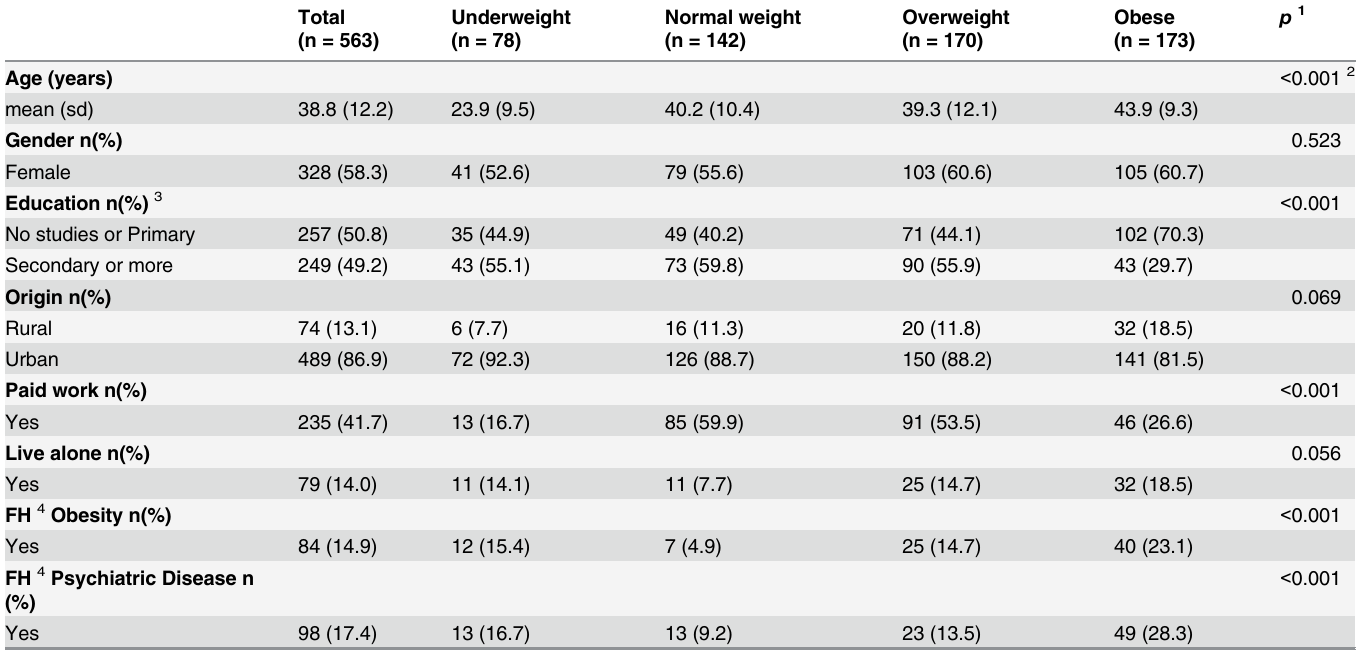
Table 1. Socio-demographic variables and their association with